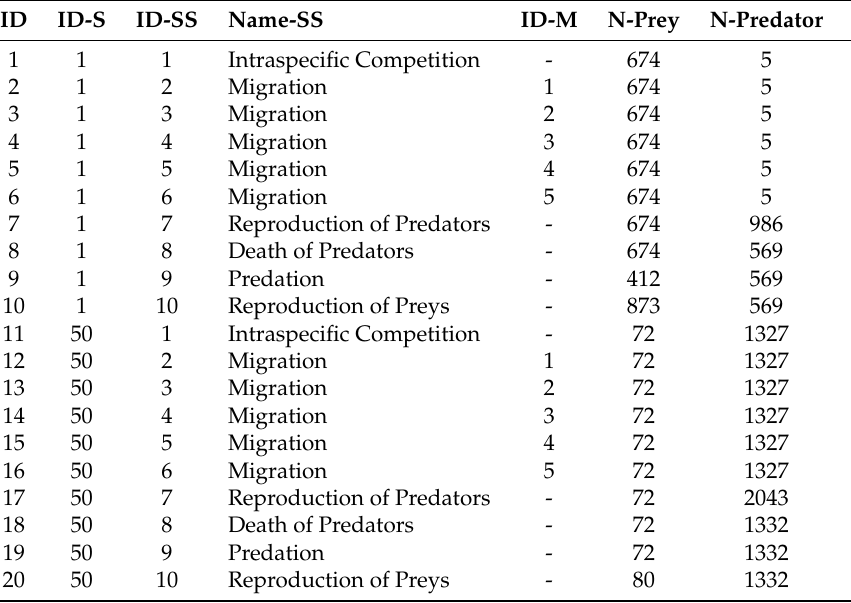
Table 4. Simulation carried out without using agents—Case